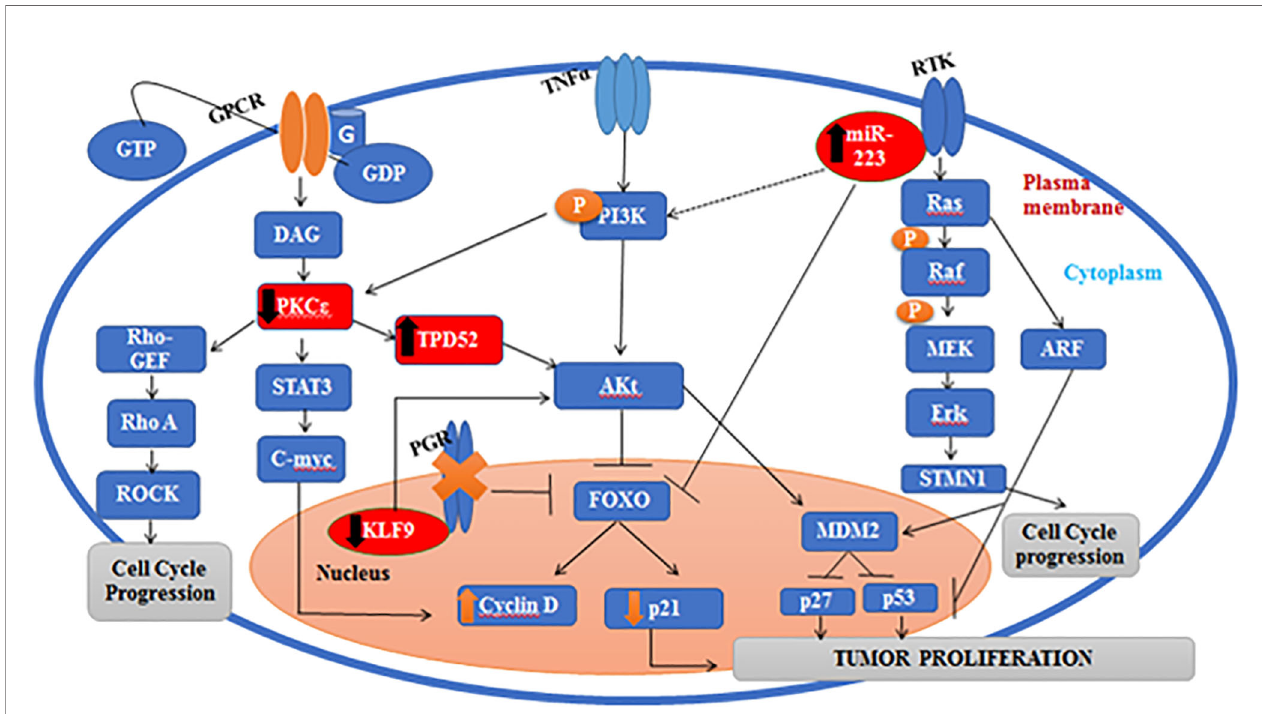
FIGURE 11 | Pathway showing the correlations between TPD52 , KLF9 , miR-223, and PKC ϵ